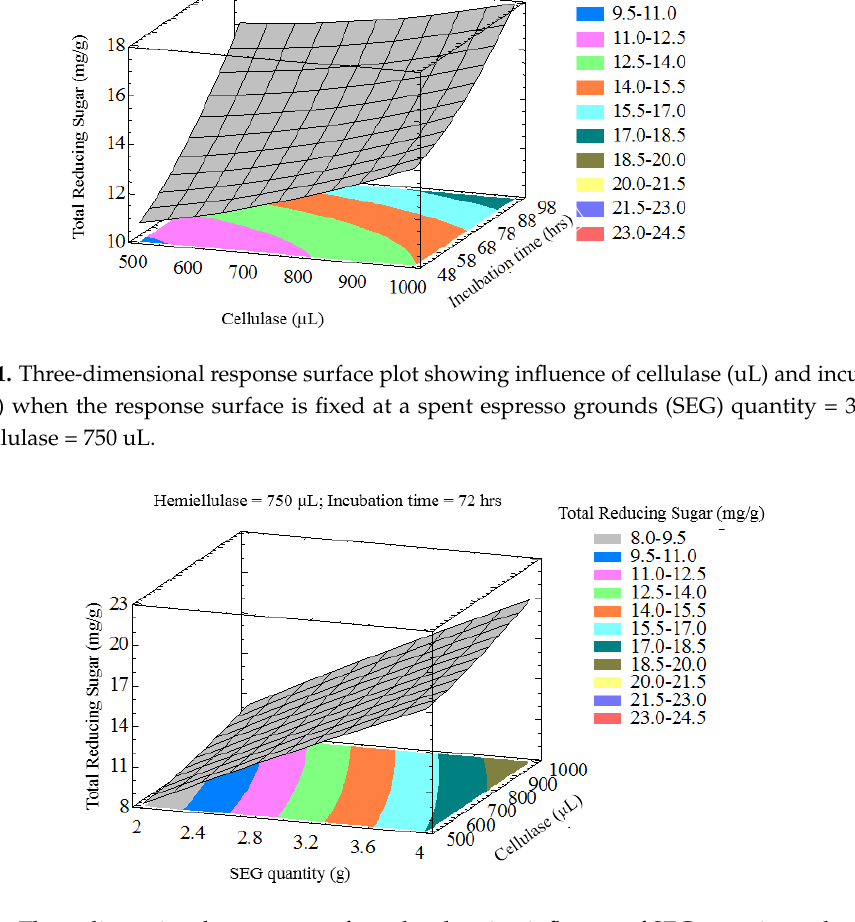
Figure 2. Three-dimensional response surface plot showing influence of SEG quantity and cellulase loading when the response surface is fixed at an incubation time = 72 h and hemicellulase = 750 uL.